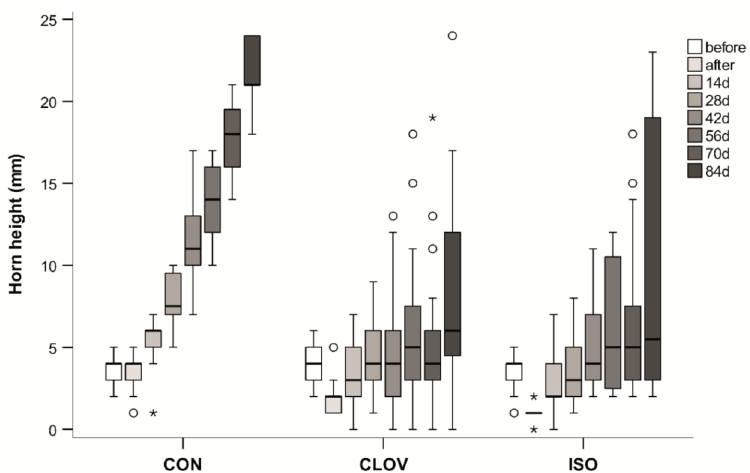
Figure 4. Horn height (in mm) of the calves in the three injection groups—saline (CON), clove oil (CLOV) and isoeugenol (ISO)—shown for different time points until week 12. The decrease at time point after in CLOV and ISO is due to swellings around the horn buds after the injection. The hot-iron treatment is not included, as no horn growth occurred. The maximum sample size was 20 horns for all treatments (2 horns/animal) at each time point; due to missing data the actual sample size was as follows: CON: 14/18/20/20/20/18/16/10; CLOV: 16/14/17/13/18/19/17/12; ISO: 16/12/20/20/19/20/16/10. The box-and-whisker-plots show the median (line in box), 25 and 75% quartile (bottom and top end of the box) and minimum and maximum (whiskers) except for outliers (circles, distance to box 1.5–3 times the interquartile range) and extreme values (asterisks, distance to box > 3 times the interquartile